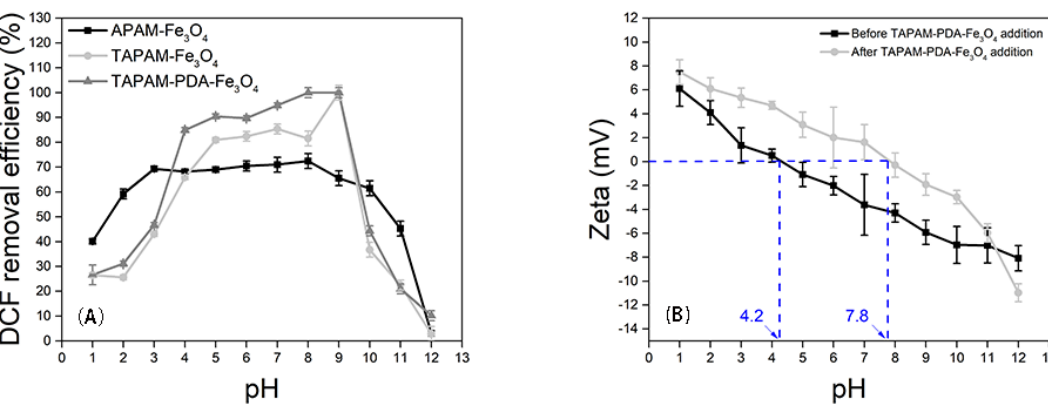
Figure 8. DCFS initial pH effect on the enrichment performance ( A ) and DCFS zeta potential at different pH before and after TAPAM-PDA-Fe 3 O 4 injection ( B ).